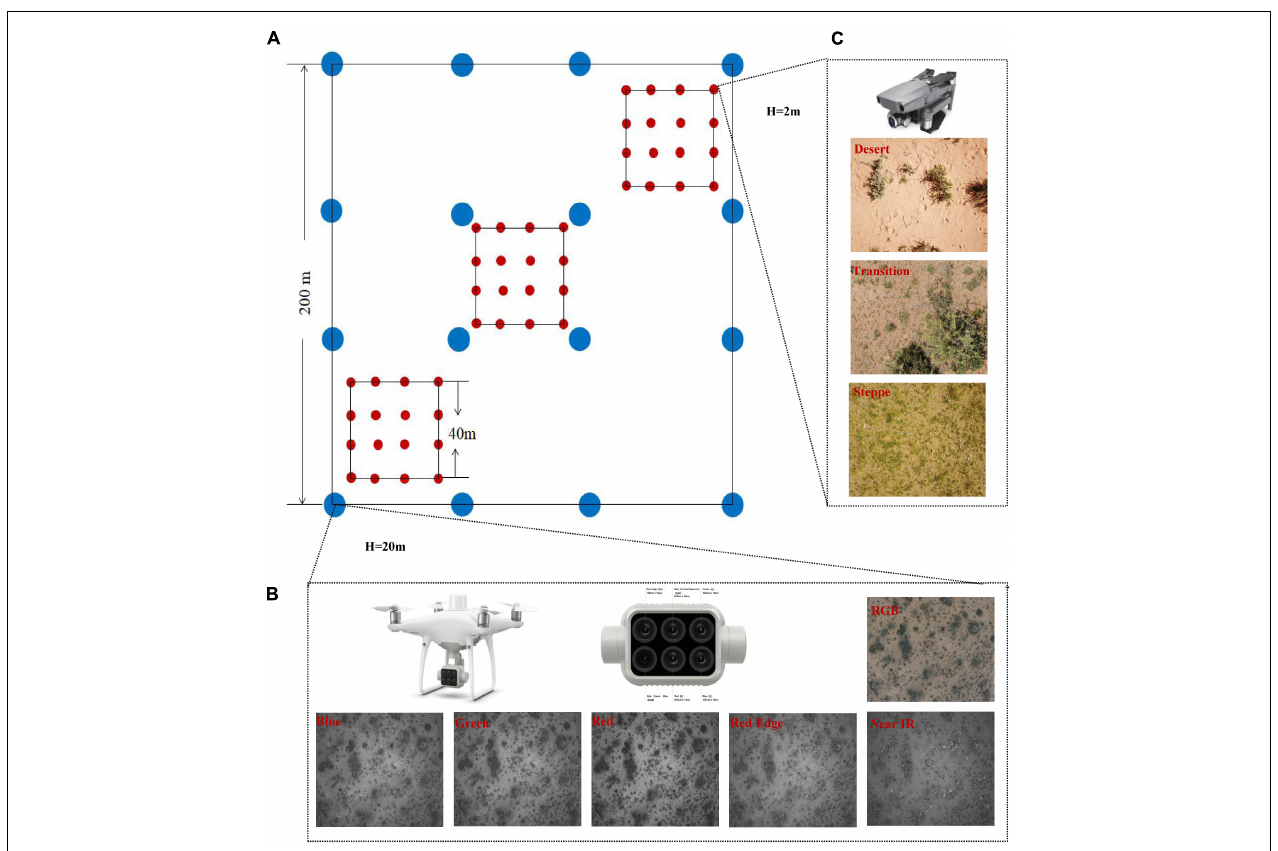
FIGURE 2 | The strategy of data collection, UAVs, and aerial photos obtained. (A) strategy of the observation sites, there are 13, 18, and 12 observation sites for desert, transition zone, and typical steppe, respectively. In each observation sites, one GRID route and three BELT routes were designed. Blue dots are the way points of GIRD route (each way point has six multi-spectra aerial photos, defined as quadrat), while red dots are those of the BELT routes (each way point has one ordinary aerial photo); (B) is the Phantom 4 UAV, the multispectral camera, and aerial photos obtained in the transition zone, including RGB, Bule, Green, Red, Red Edge, and Near IR; (C) is the Mavic 2 zoom UAV, and aerial photos obtained from desert, transition zone, and typical steppe,